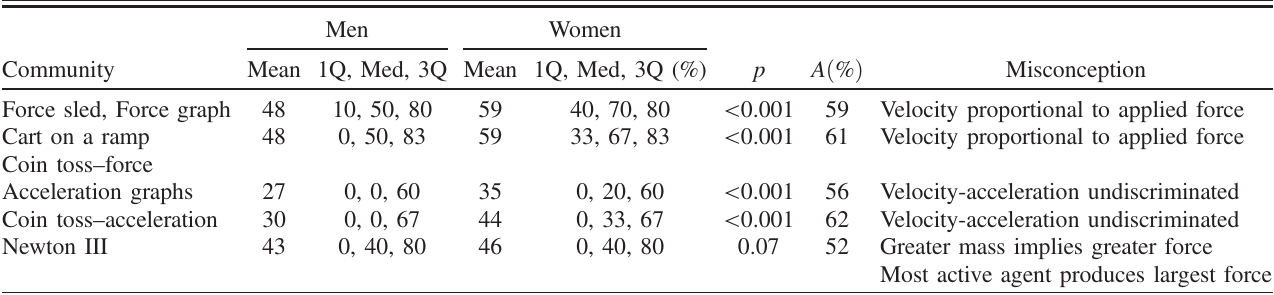
TABLE IV. Percentage of students selecting each incorrect community for the FMCE post-test; mean, 1st quartile (1Q), median (med), and 3rd quartile (3Q). A Mann-Whitney U test was performed to determine if the differences between men and women were significant, the p value is presented. The effect size is given as Vargha and Delaney ’ s A [62], the probability that a randomly selected woman will score higher than a randomly selected